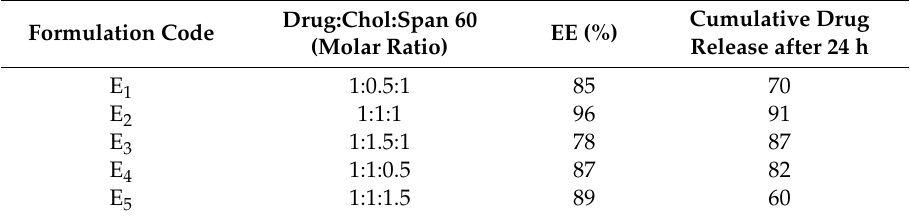
Table 11. Composition molar ratios, entrapment e ffi ciency (EE %) and 24 h cumulative drug release for the di ff erent niosomal